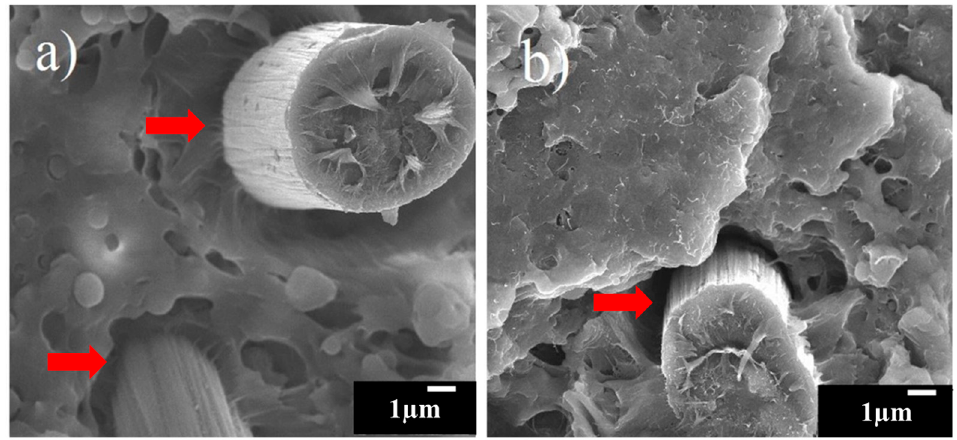
Figure 9. FE-SEM images of ( a ) CNT agglomeration in the fracture surface of CF-reinforced PA6/PP composites (30 wt % PP) with 1.5 wt % CNTs and ( b ) its enlarged image.